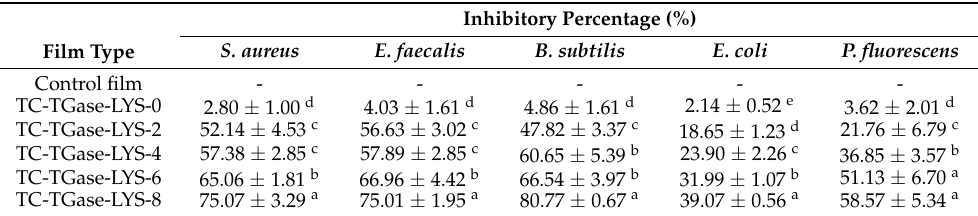
Table 4. The inhibitory percentage (%) of transglutaminase (TGase) cross-linked tilapia collagen (TC) films incorporated with lysozyme